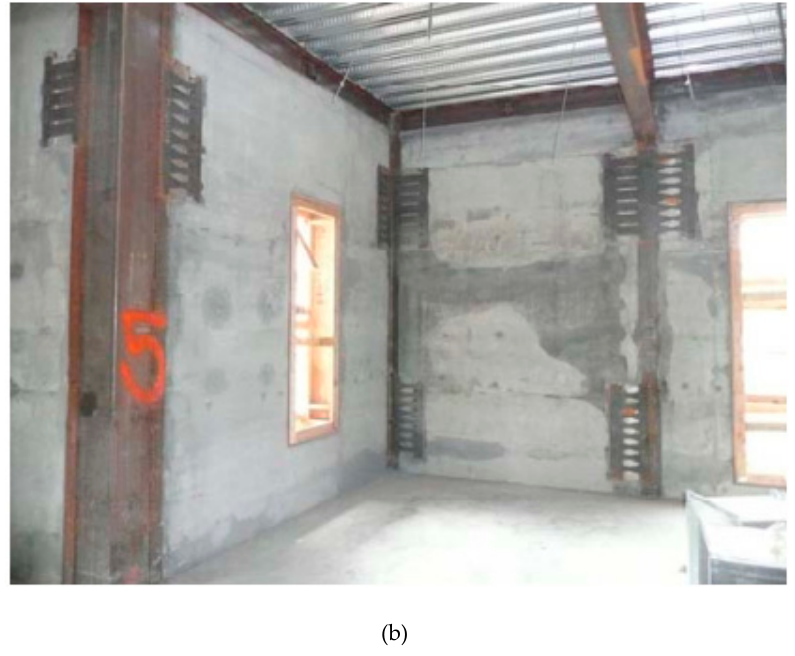
Figure 2. Implementation of the butterfly-shaped hysteretic damper. ( a ) Butterfly-shaped fuses in multi-story buildings; ( b ) Butterfly-shaped fuses used to enhance energy dissipation (from [8] ).